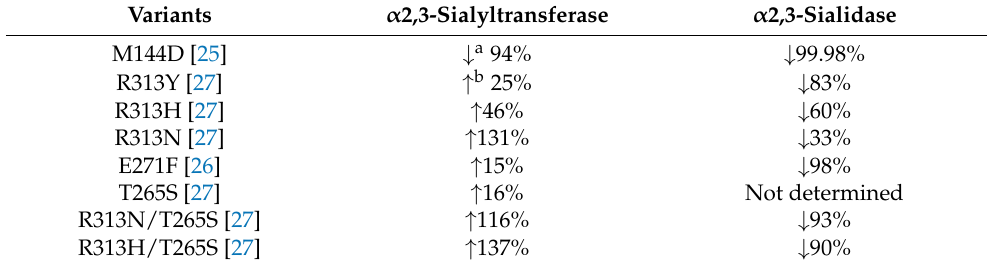
Figure 4. Comparison of α 2,3-sialyltransferase ( A ) and α 2,3-sialidase ( B ) activities of M144D, PMG1, PMG2 and PMG3. For the α 2,3-sialyltransferase activity assay, the reaction mixture (800 μ L) con- taining Tris-HCl (100 mM, pH = 8.5), 20 mM MgCl 2 , 3 mM lactose, 3.6 mM Neu5Ac and 3.6 mM CTP was incubated with NmCSS (0.2 mg/mL) and a variant enzyme (0.25 mg/mL) at 37 °C for different periods. For the α 2,3-sialidase activity assay, the reaction mixture (800 μ L) containing MES buffer (100 mM, pH = 5.5) and 20 mM MgCl 2 was incubated with 3 mM 3 ′ -SL, a variant enzyme (2.5 mg/mL), at 37 °C for different periods. At different time points, 25 μ L of the sample was transferred into an Eppendorf tube, and 25 μ L cold ethanol was added. The mixture was kept at 4 °C for 30 min, then centrifuged at 12,000 rpm for 10 min and the precipitates were removed. The supernatants were used for analysis. All reactions were done in triplicate.